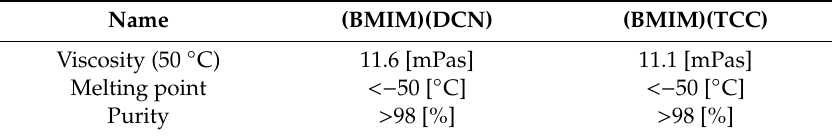
Table 2. Physical properties of the ionic liquids.